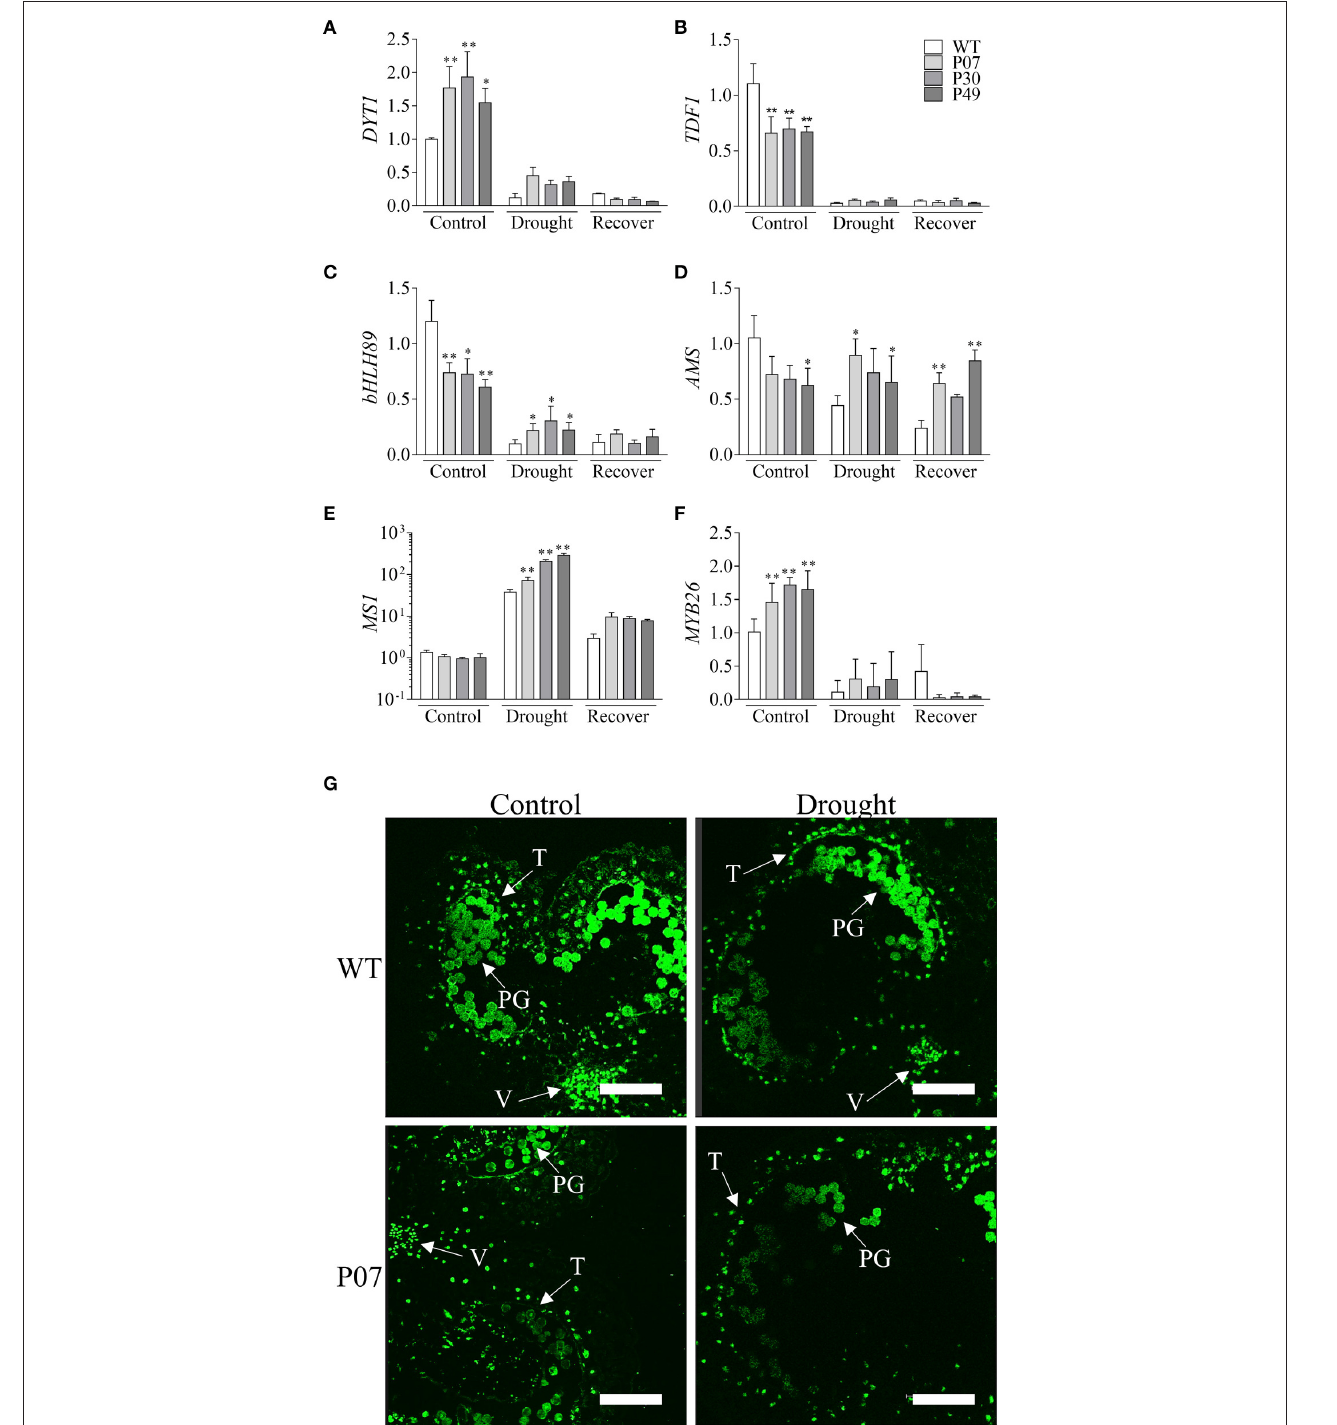
FIGURE 11 | Overexpression of AtUCP1 impacts the expression of anther-specific transcription factors but does not affect tapetum PCD during drought stress. We evaluated the expression of transcription factors that regulate the beginning of tapetum development, tapetal maturation and anther maturation. The values of (A) DYT1 , (B) TDF1 , (C) bHLH89 , (D) AMS, (E) MS1, and (F) MYB26 are displayed as the amounts of relative expression compared to those of WT under control conditions. (G) A TUNEL assay was performed in WT and P07 lines under both control and drought stress conditions. A TUNEL signal can be seen in the tapetum cells; autofluorescence/TUNEL signal was observed in the pollen grains. V, vascular bundle; PG, pollen grains; T, tapetum. Bars represent the means of 5 plants ± SD. Points with * and ** differ significantly from the WT ( P < 0.1 and P < 0.05, respectively). Scale bars = 150 µ m.